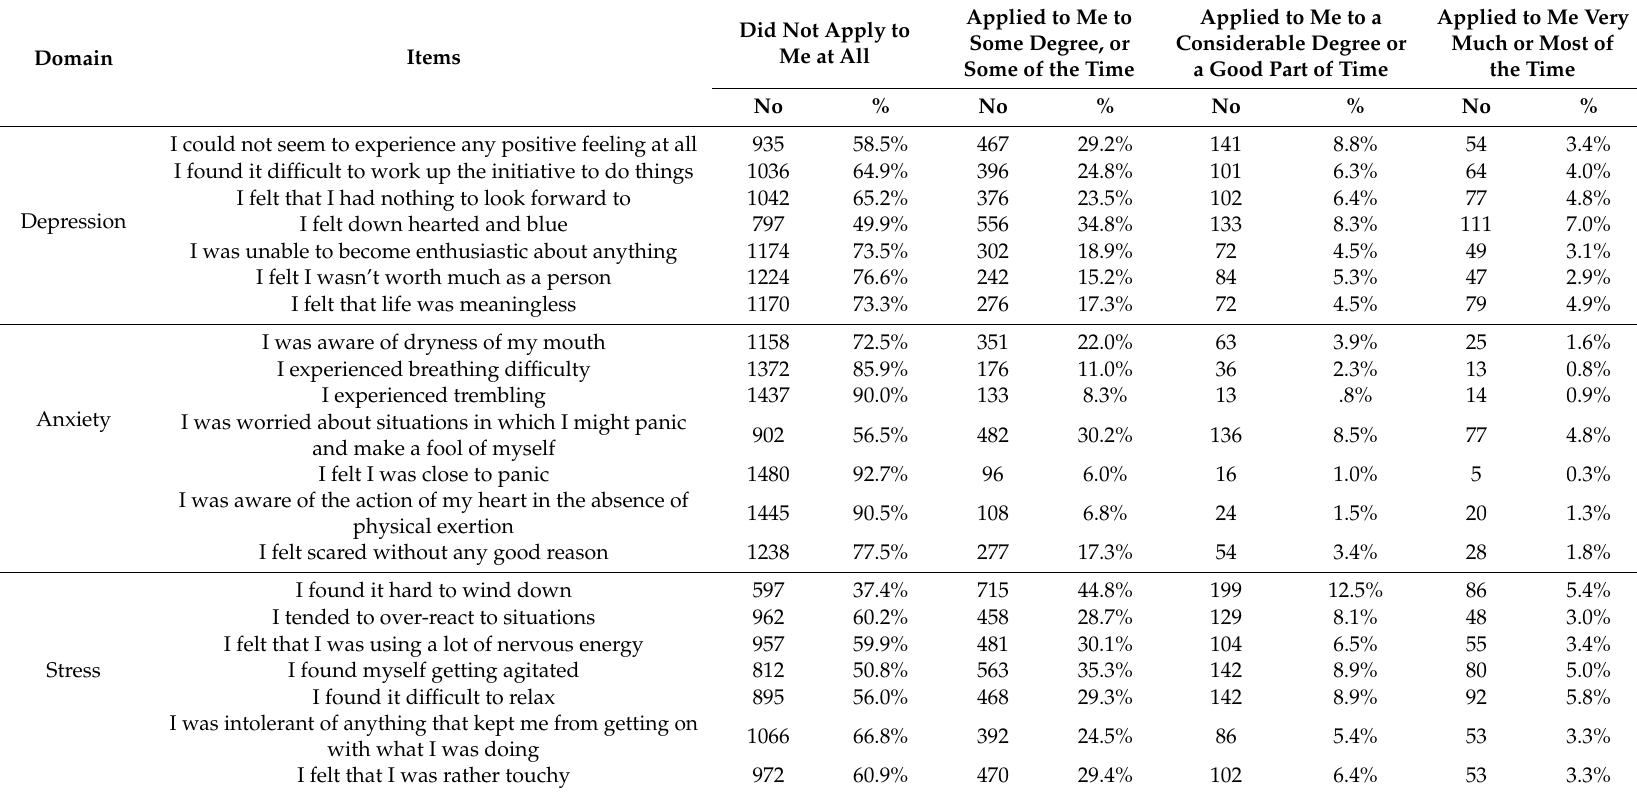
Table 4. Depression, Anxiety, and Stress Scale (DASS) distribution among survey participants during COVID-19, Saudi Arabia,